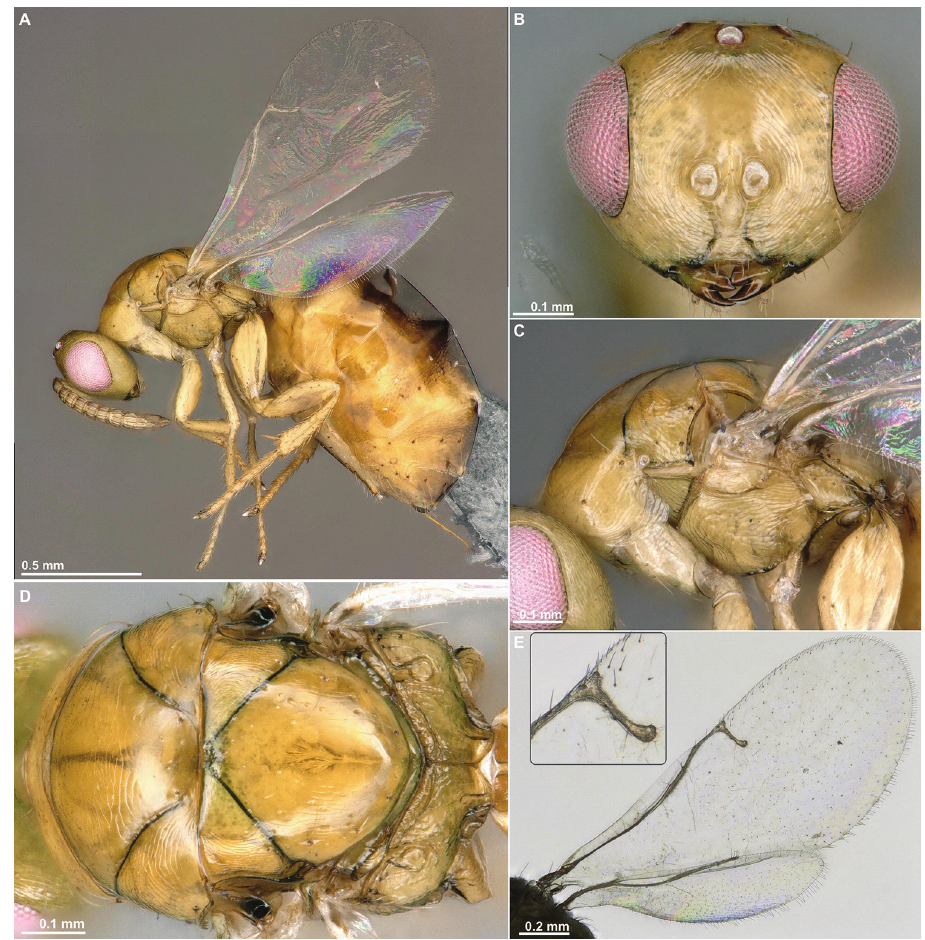
Figure 4. Sycobia hodites Farache & Rasplus, sp. n. Female. A Habitus, lateral view B Head, frontal view C Mesosoma, lateral view D Mesosoma, dorsal view E Wings and detail of venation. Ovipositor teeth of homogeneous height; ovipositor with scale-like projections located just before the ovipositor teeth. Measurements (µm). Posterior ocellar distance 133; ocellocular distance 88; lateral ocellar line 67. Antennomeres length): scape 159; pedicel 63; anellus 10; F(unicle)1 52; F2 48; F3 54; F4 52; F5 53; F6 55; clava 146. Forecoxa length 233; forefemur 303; foretibia 303; foretarsomere (FoT): FoT1 75; FoT2 39; FoT3 40; FoT4 22; FoT5 43. Metacoxa length 366; metafemur 384; metatibia 412; metatarsomeres (MtT): MtT1 208; MtT2 63; MtT3 50; MtT4 34; MtT5 52. Winged male (Fig. 6). Mostly similar to female. Body length 2 mm. Body color mostly pale yellow. Head . Mandibles and oral margin brown. Metasoma dorsally brown. Head square to transverse, 1.1× as wide as high. Toruli contiguous.